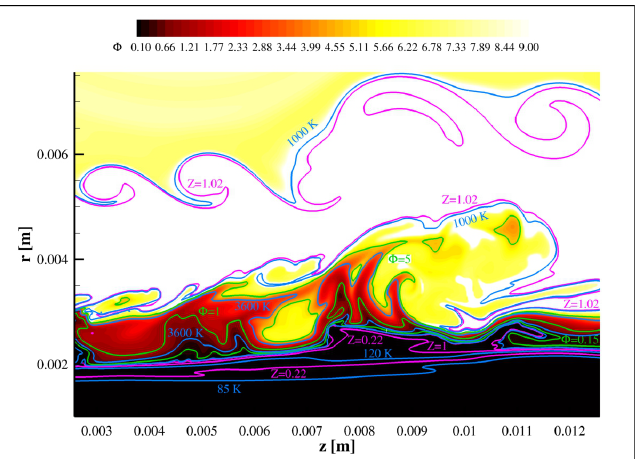
Figure 12. Instantaneous zoomed-in view of the equivalence ratio Φ close to the injector: three levels, 0.15, 1 (corresponding to the stoichiometric mixture fraction Z = 0.11) and 5 are marked as green iso-lines. Some temperature iso-lines are shown in blue, while some compressibility factor iso-lines are in purple.